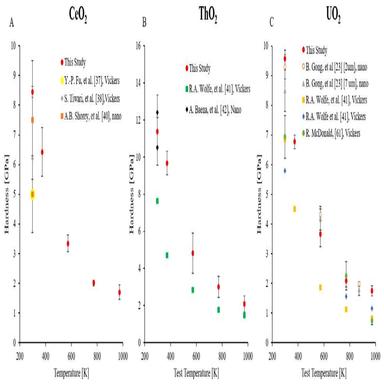
The nanoindentation hardness of the oxide fluorite structure materials over testing temperature. At each test temperature on each sample a minimum of 16 indents was performed with a 20 μm spacing. (A) CeO2, (B) ThO2 and (C) UO2.